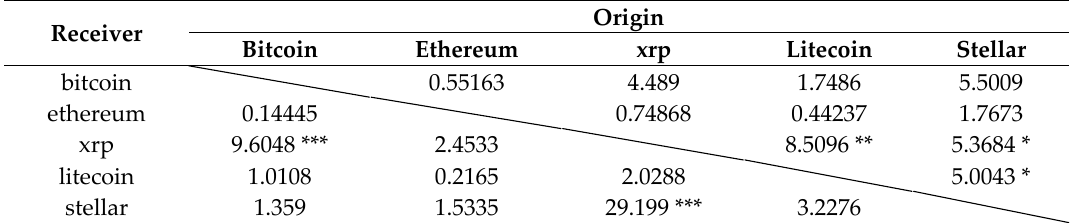
Table 4. VAR Granger causality results 5 .